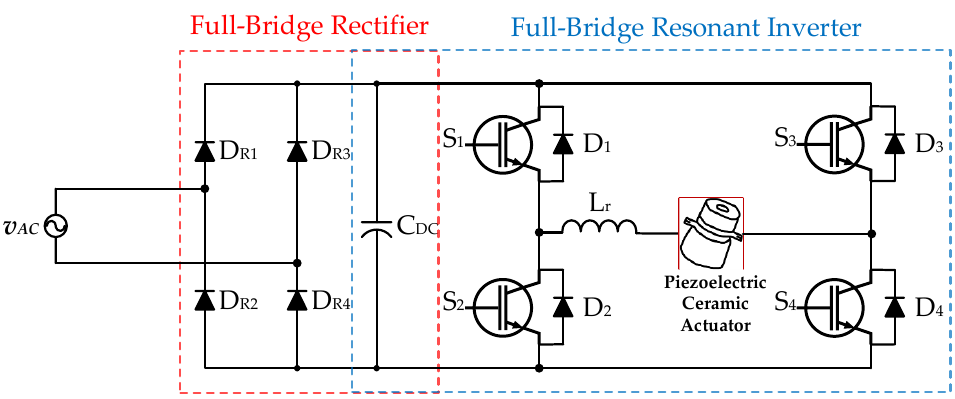
Figure 4. The conventional two-stage drive circuit for supplying a piezoelectric ceramic actuator applied with an AC input voltage source without PFC [13,14].